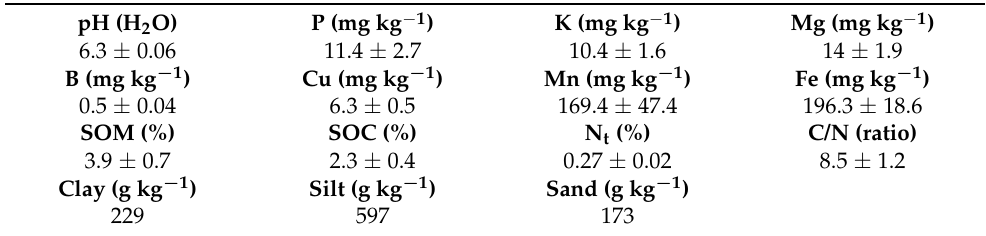
Table 1. Basic soil properties. Values show means and standard deviation ( n = 5; for SOM, SOC, N t , C/N: n = 6); SOM = soil organic matter; SOC = soil organic